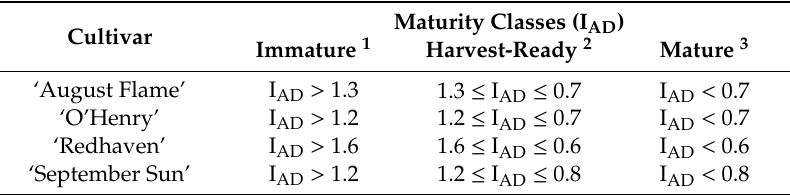
Table 1. Fruit maturity classes for yellow-flesh peach based on cultivar-specific thresholds of index